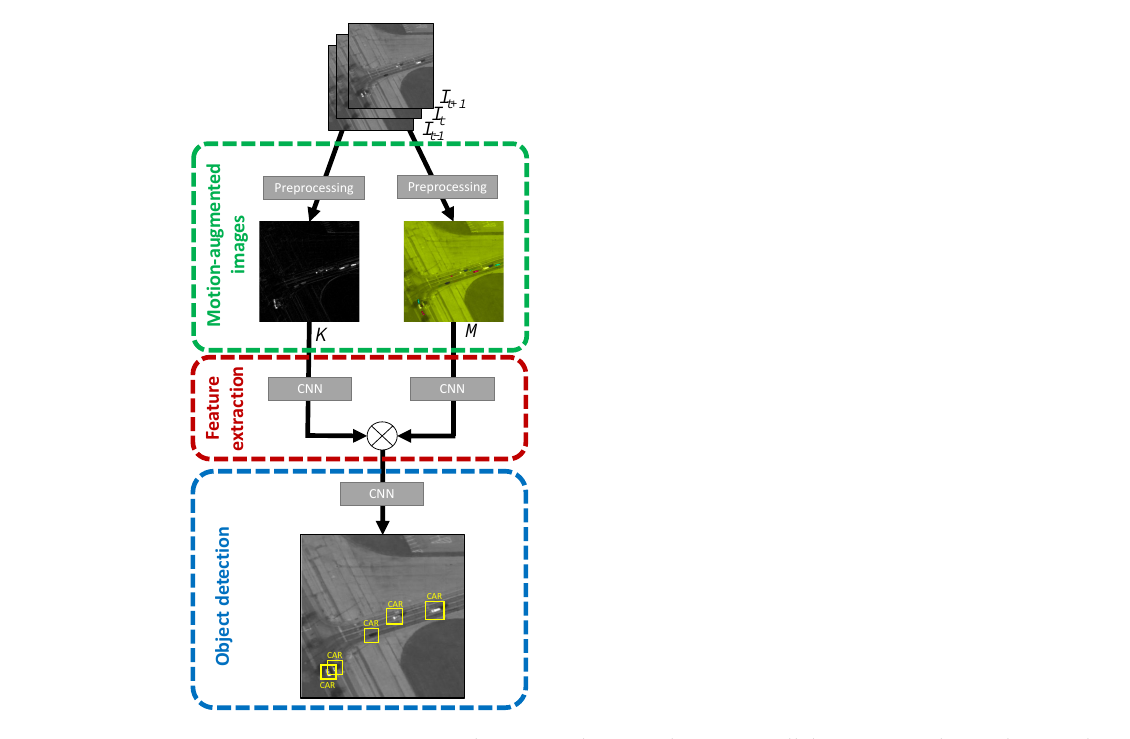
Figure 3. T-RexNet macro architecture, showing the two parallel “Motion-only” and “Mixed Visual- Motion” MobileNetv2-Based feature extractors. Their output is concatenated and then processed by an SSD